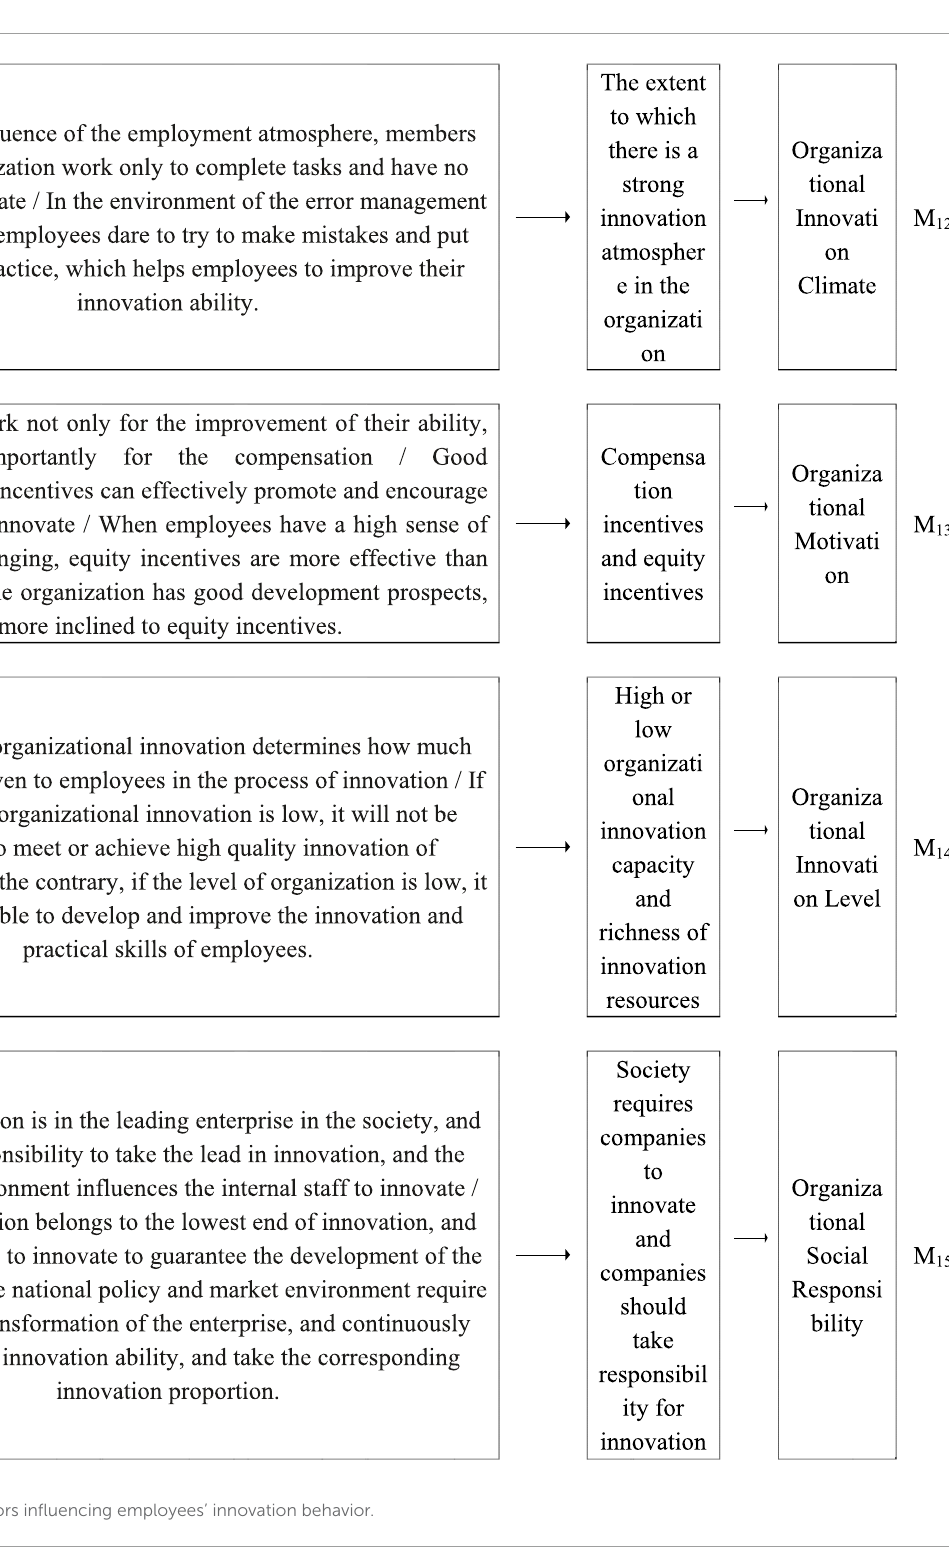
to construct the recursive structural relationship model of the factors influencing employee innovation behavior in this study, as shown in Figure 3